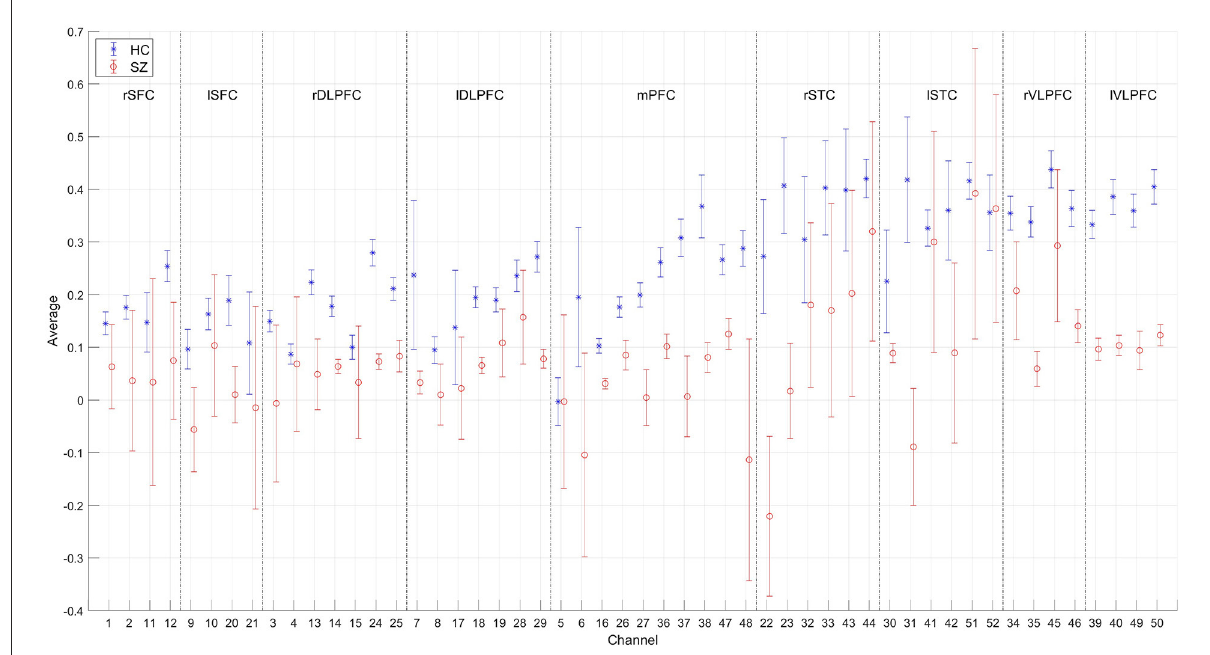
FIGURE8 Time-domain feature of 52 channels averaged for the HCs and SZs during the VFT, respectively. The error bars were drawn with standard errors.